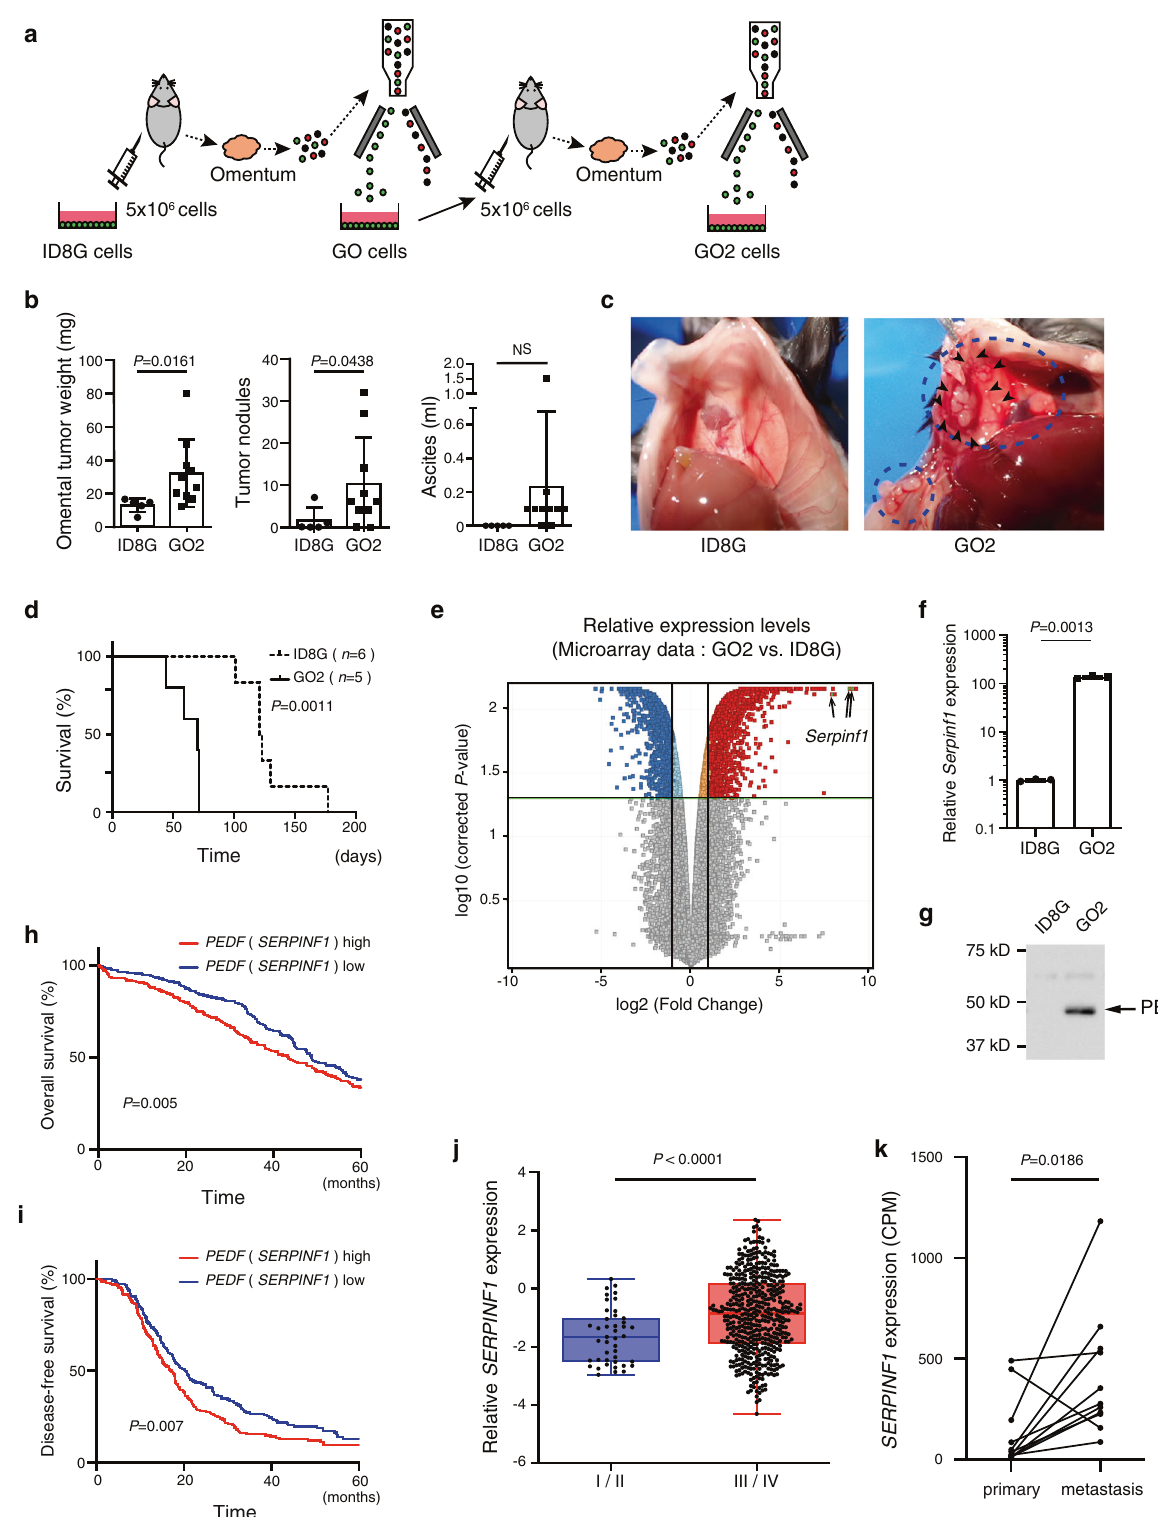
PEDF promotes peritoneal dissemination of both mouse and human OC cells . To clarify the role of PEDF expression in intraperitoneal dissemination of OC, we stably infected ID8G cells with a retrovirus that encodes mouse PEDF (ID8G-PEDF cells) or with corresponding empty vector (ID8G-EV cells). The abundance of PEDF mRNA and secretion of PEDF protein were increased in ID8G-PEDF cells compared with ID8G-EV cells